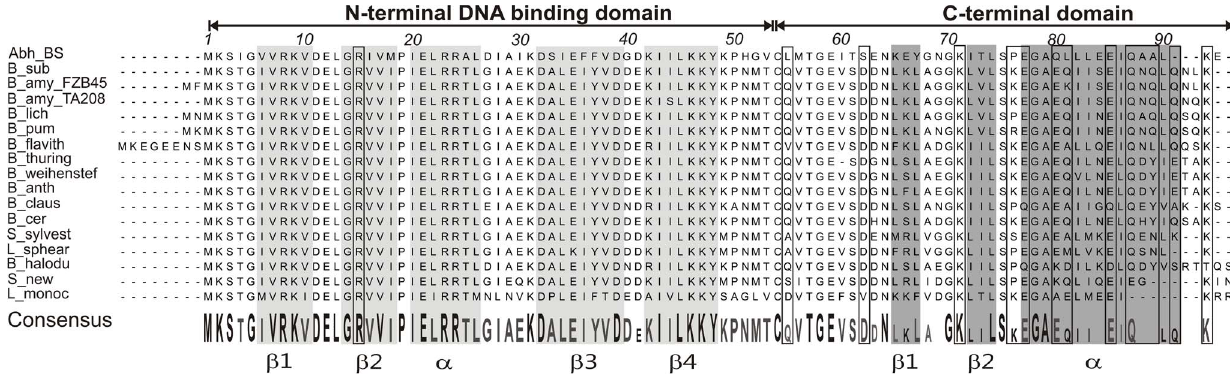
Figure 1. Amino acid alignment of AbrB-like proteins of Bacillus related species. N- and C-terminal domains are indicated on the top. Known conserved structures of the DNA-binding domain ( b 1-4 and a ) are highlighted in gray according to (7). The structured regions ( b 1-2 and a ) of the C-terminal domain of AbrB from B. subtilis are highlighted in dark gray according to Olson et al. [28]. Amino acid residues that were subjected to the substitution are framed. The consensus sequence resulting from this alignment is given on the bottom and the sizes of the amino acid code indicate the percentage of the similarity (100%, 77%, 65% and 42%). Abh_BS = Abh protein of B. subtilis 168, B_sub = B. subtilis 168, B_amy_FZB45 = B. amyloliquefaciens FZB45, B_amy_TA208= B. amyloliquefaciens TA208, B_lich = B. licheniformis ATCC14580, B_pum = B. pumilus SARF-032, A_flavith = Anoxybacillus flavithermus WK1, B_thuring = B. thuringensis Al Hakam, B_weihenstef = B. weihenstefanansis KBAB4, B_anth = B. anthracis A0248, B_claus = B. clausii KSM-K16, B_cer = B. cereus ATCC14579, S_silvest = Solibacillus silvestris StLB046, L_shearic = Lysinibacillus sphearicus C3-41, B_halodu = B. halodurans C-125, S_new = Sporosarcina newyorkensis 2681, L_monoc = Listeria monocytogenes L312